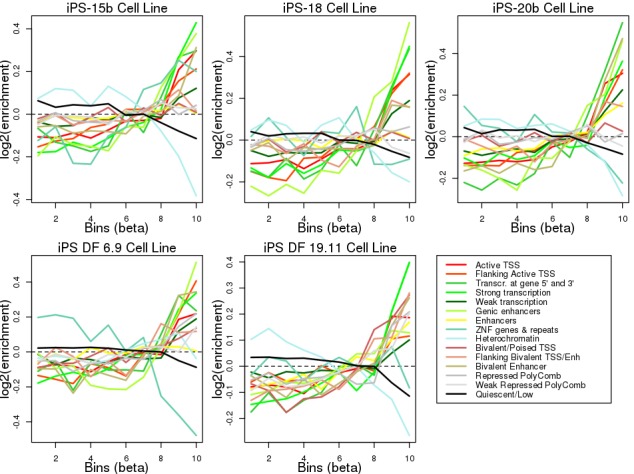
Enrichment of eQTLs in regulatory elements.Plots showing the log2 enrichment of each chromatin mark in each of five Roadmap iPSC lines across ten eQTL effect size bins (X axis). To determine if the MHC eQTLs were enriched for localization in regulatory elements, we tested their overlap with chromatin states in five iPSC lines from the Roadmap Epigenomics Consortium (Kundaje et al., 2015). We determined the overlap of each of the 45,245 variants tested for eQTLs with 15 ChromHMM chromatin states (Ernst and Kellis, 2012) in each Roadmap iPSC line, divided all eQTLs into bins according to their absolute effect size and calculated the relative enrichment for each chromatin state in each bin (see Materials and methods). We observed that, across all five iPSC lines, larger effect size bins (corresponding to stronger eQTLs) were enriched for including variants at active transcription start sites (TSS), regions flanking active TSS, UTRs (defined as regions transcribed at 5’ and 3’), transcribed regions and, in two iPSC lines (iPS-20b and iPS DF 19.11) enhancers. Conversely, strong effect size bins were depleted for quiescent regions, heterochromatin and ZNF genes and repeats. These results show that eQTLs in the MHC region are enriched for occurring in regulatory elements active in iPSCs.